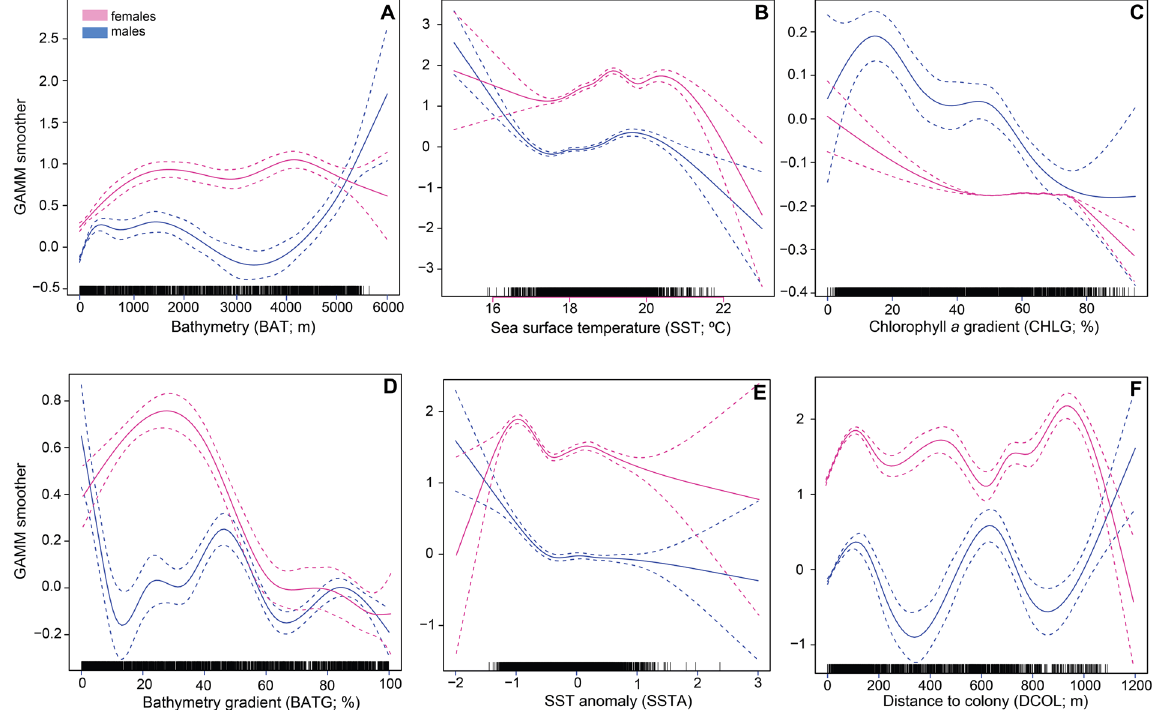
Figure 2. Response curves of the most important variables explaining the foraging distribution of male (blue) and female (pink) Cory’s shearwaters. Habitat selection functions for ( A ) bathymetry, ( B ) sea surface temperature, ( C ) chlorophyll a gradient, ( D ) bathymetry gradient, ( E ) sea surface temperature anomaly and ( F ) distance to land. Plots show the predicted curve from the best models (solid lines) and 95% confidence intervals (dashed lines) for male (blue) and female (pink) Cory’s shearwaters. GAMM – Generalized Additive Mixed